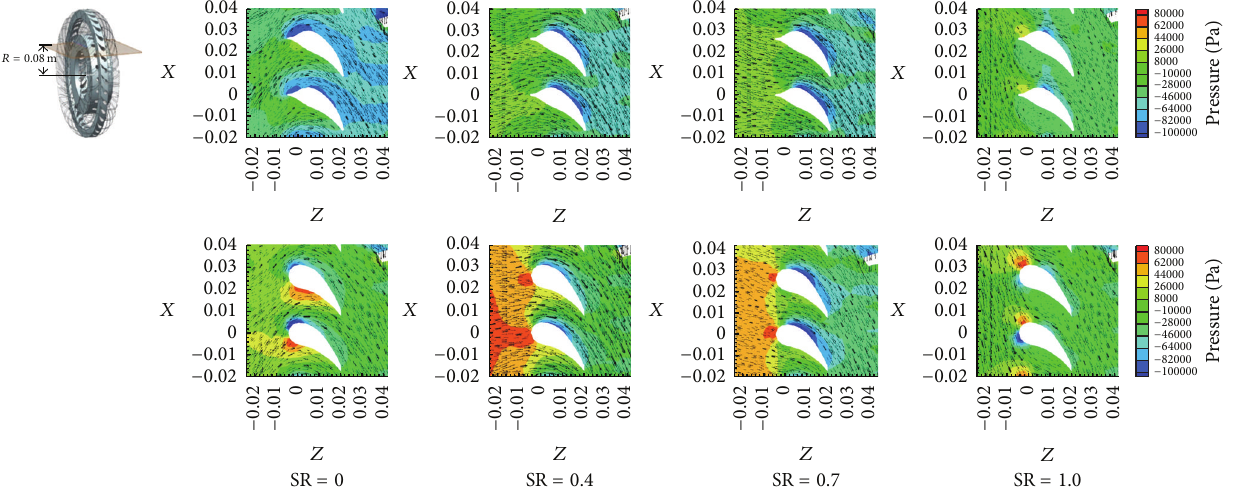
Figure 15: Pressure-velocity vector distribution on suspension of stator on SR =